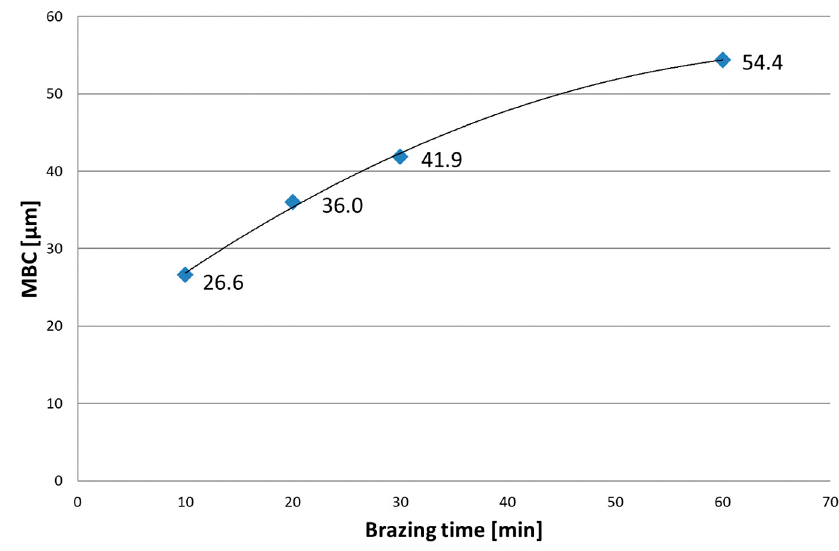
Figure 3. Impact of brazing time on MBC in Hastelloy X–Ni ‐ Pd ‐ Cr ‐ B ‐ Si joints.